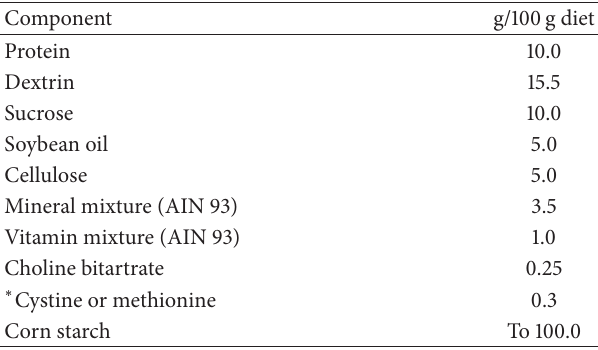
Table 1: Compositions of the